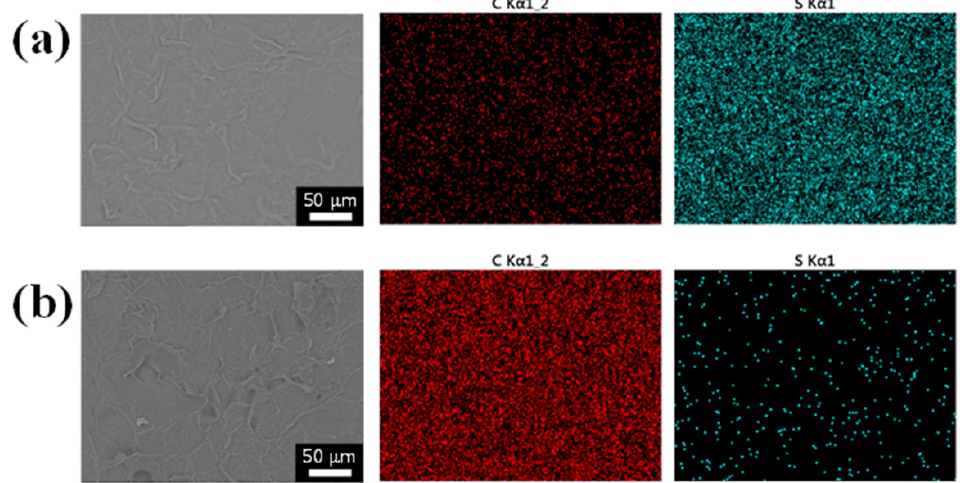
Figure 9. SEM and EDS mapping images of EEG/PEDOT:PSS composite electrodes on the polyimide substrate printed at ( a ) 60 °C and ( b ) 80 °C.